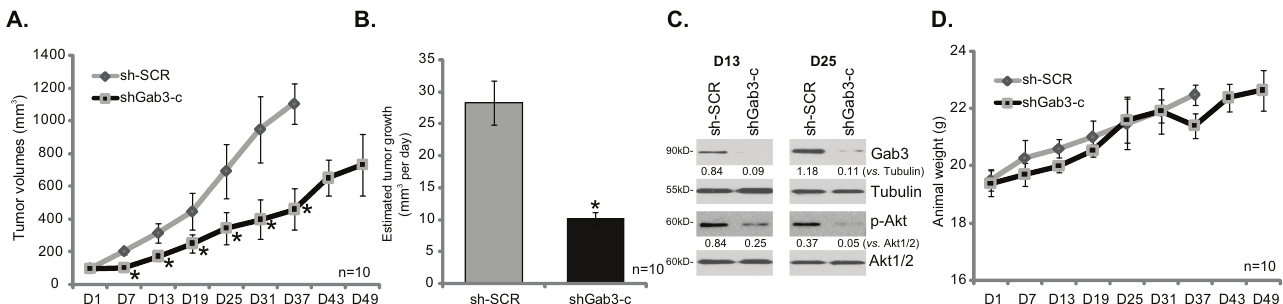
Fig 6. Gab3 knockdown suppresses U251MG xenograft tumor growth in nude mice. The exact same amount of stable U251MG cells (1 * 10 7 cells per mouse), expressingscramble control shRNA (“sh-SCR”) or Gab3 shRNA (shGab3-c), were inoculated s . c . into the flanks of mice to establishU251MG xenografts. Tumor volumes (A) and mice body weights (D) were recordedevery 6 days; Estimated daily tumor growth was calculated(B); At Day-13 and Day-25, one U251MG tumor per group was isolated,expressionof the listed protein in the fresh tumor lysates was tested by Western blotting assay (C), relative expressionof listed proteins was quantified(C, vs . Akt1/2 or Tubulin). * p < 0.05 vs . “sh-SCR” tumors.